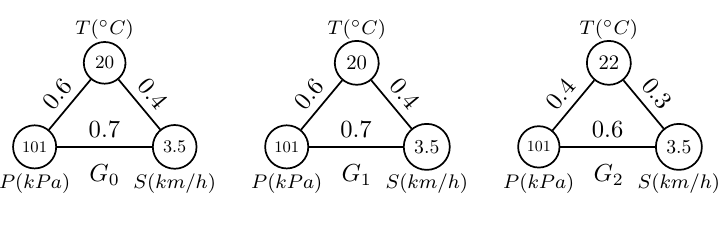
Figure 1. Example of an abnormal climate